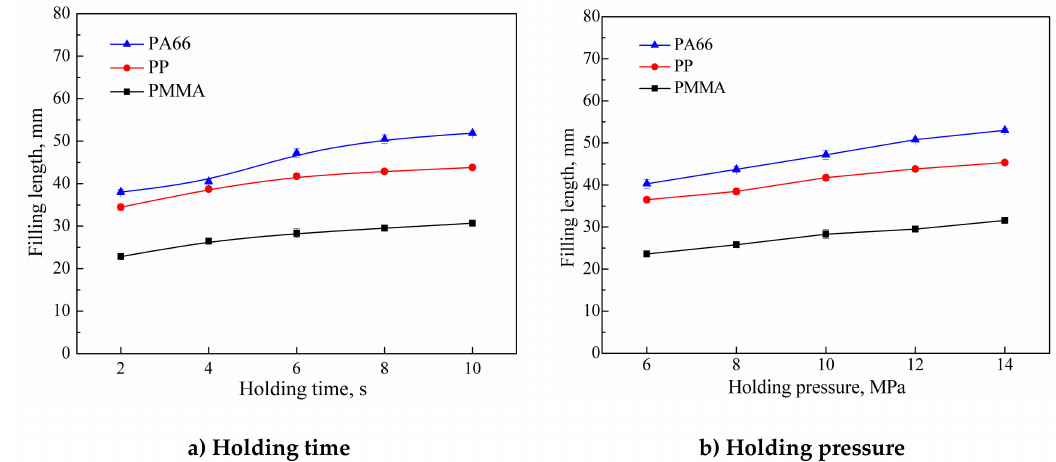
Figure 5. Effects of the holding process on the filling length of polymer melt (UA = 40 µ m, UT = 6 s, PPe = 14 MPa, MT = 60 °C; Mold I).